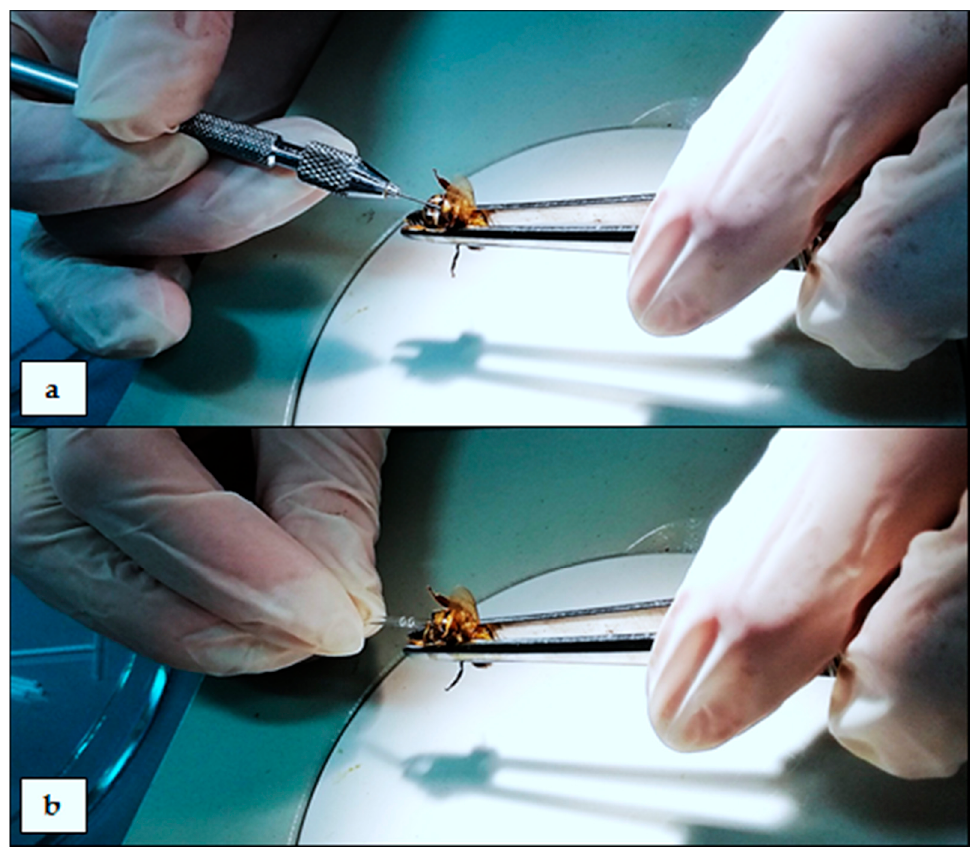
Figure 4. A demonstrative photo of the technique of collecting hemolymph into a glass capillary